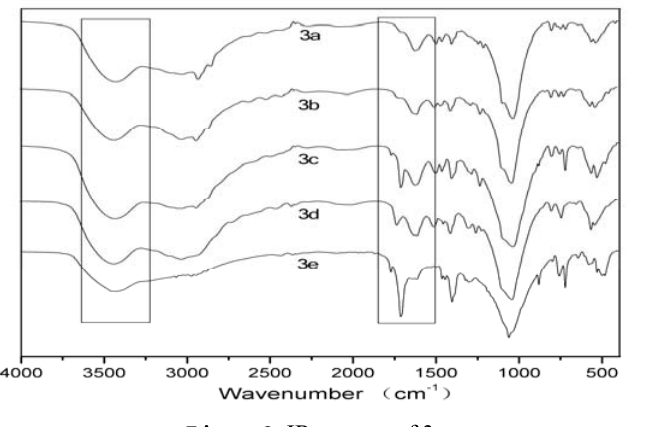
Figure 2. IR spectra of